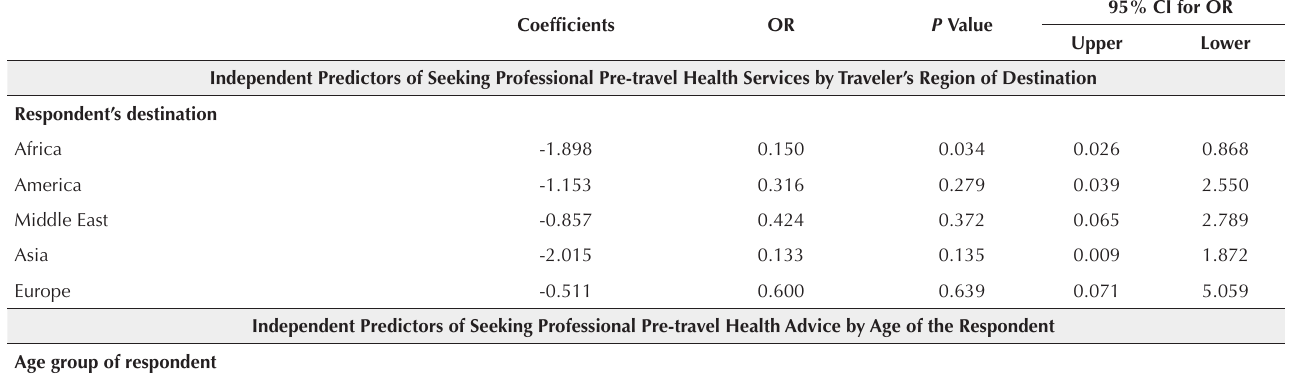
Coefficients OR P Value